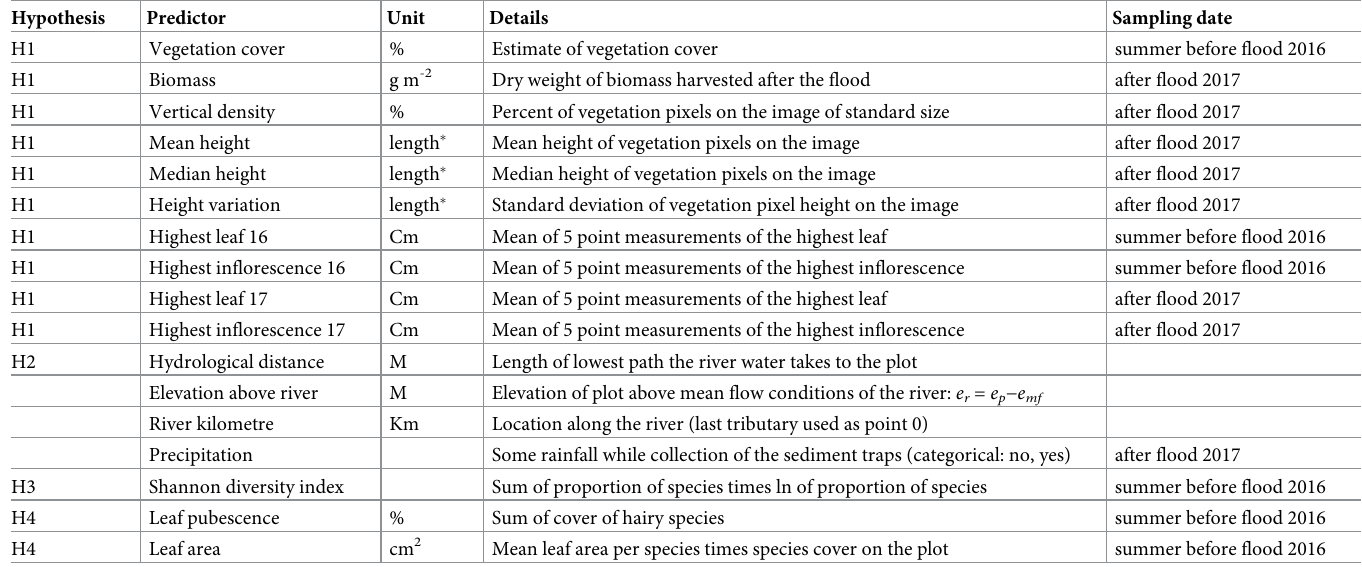
normalised and resampled from a resolution of 4000 by 6000 pixels to a resolution of 400 by 600 pixels and afterwards transformed into grey-scale images. In order to perform a binary classification of the image into vegetation and background, we used the otsu-tresholding Table 1. List of predictor